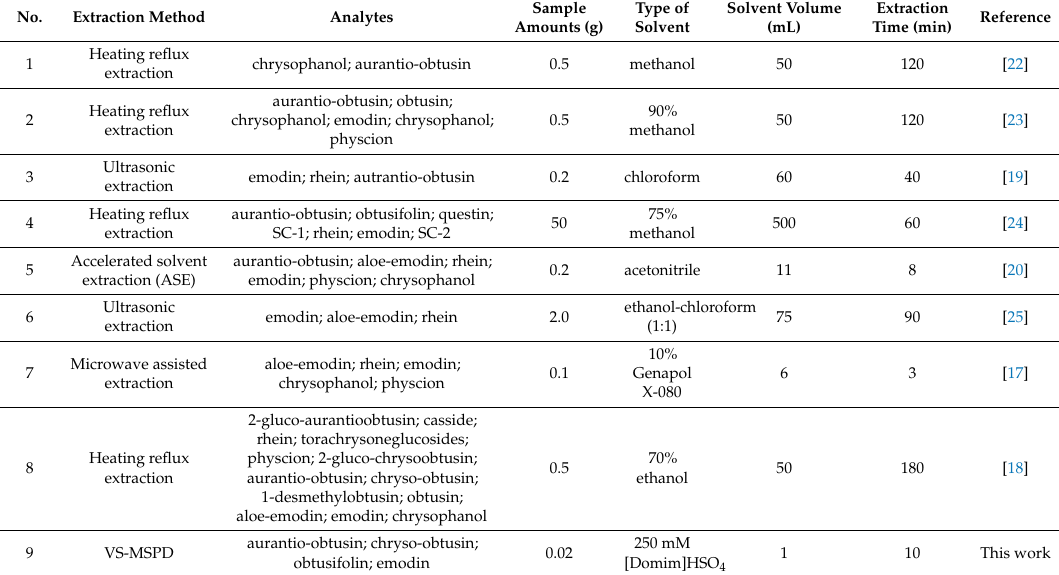
Table 4. Comparison of VS-MSPD method with other methods in the determination of compounds in Cassiae